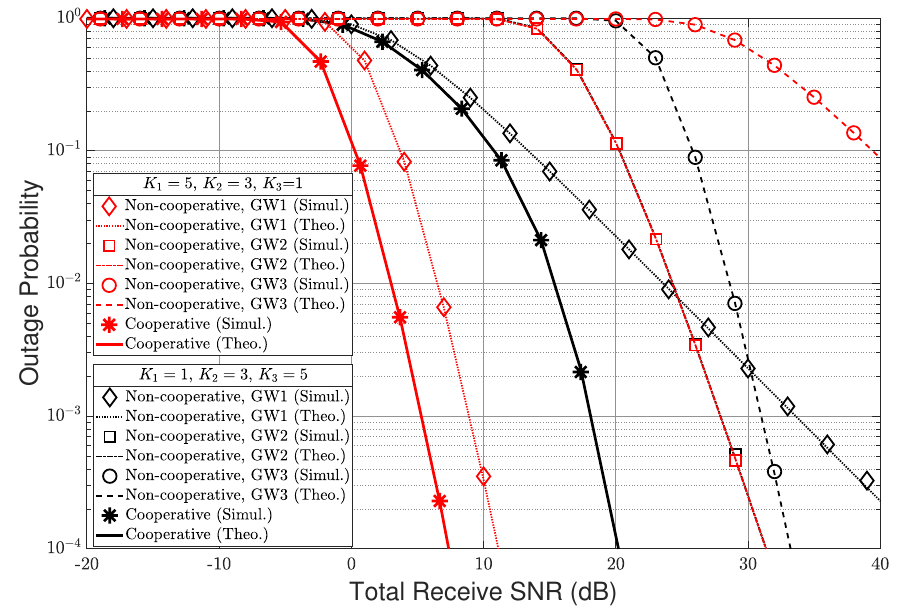
Figure 2. Outage probability performance of the LPWAN while varying the total received SNR when N = 3, ( K 1 , K 2 , K 3 ) ∈ { ( 1,3,5 )( 5,3,1 ) } , d 1 = 1, d 2 = 4, d 3 = 8, R = 1.5, and α =